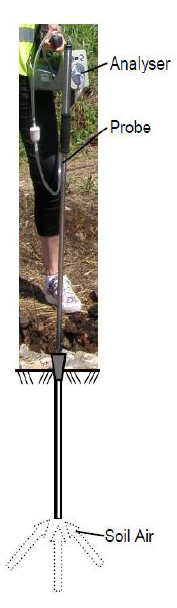
Figure 1. Analysis of soil air pollution.